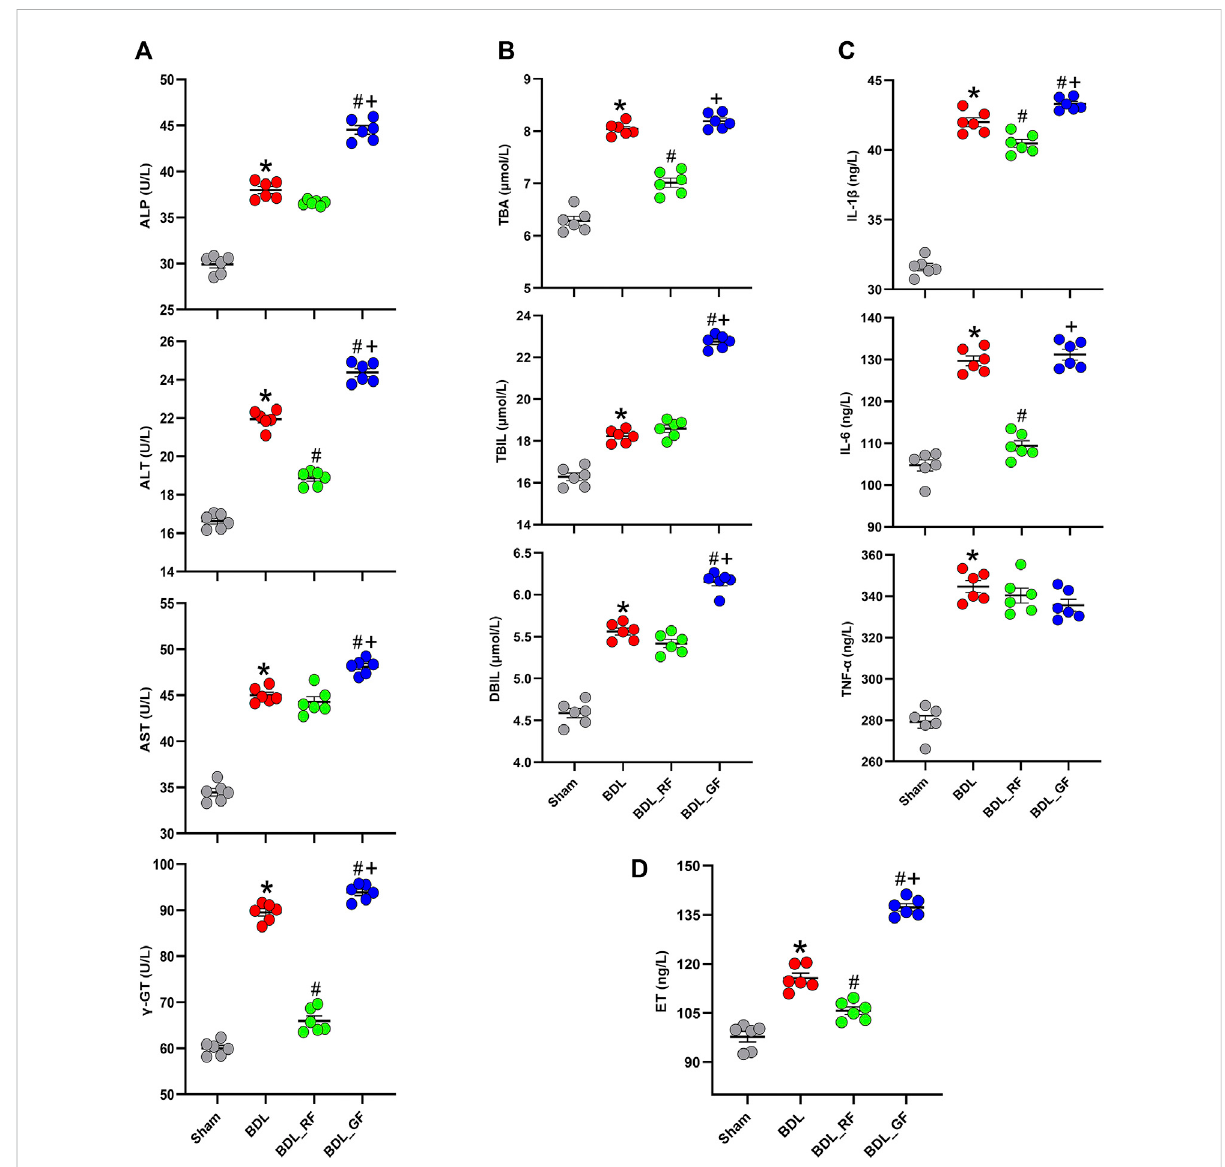
FIGURE 4 Effects of RF and GF on serum biochemical indicators of BDL-rats. (A) Serum levels of alkaline phosphatase (ALP), alanine aminotransferase (ALT),aspartateaminotransferase(AST),and γ -glutamyltranspeptidase( γ -GT). (B) Serumlevelsoftotalbileacid(TBA),totalbilirubin(TBIL),anddirect bilirubin(DBIL). (C) Serumlevelsofinterleukin-1 β (IL-1 β ),interleukin-6(IL-6),andtumornecrosisfactor- α (TNF- α ). (D) Serumlevelsofendotoxin(ET). (*: p < 0.05, compared with the Sham group; #: p < 0.05, compared with the BDL group; +: p < 0.05, compared with the BDL_RF group, n =